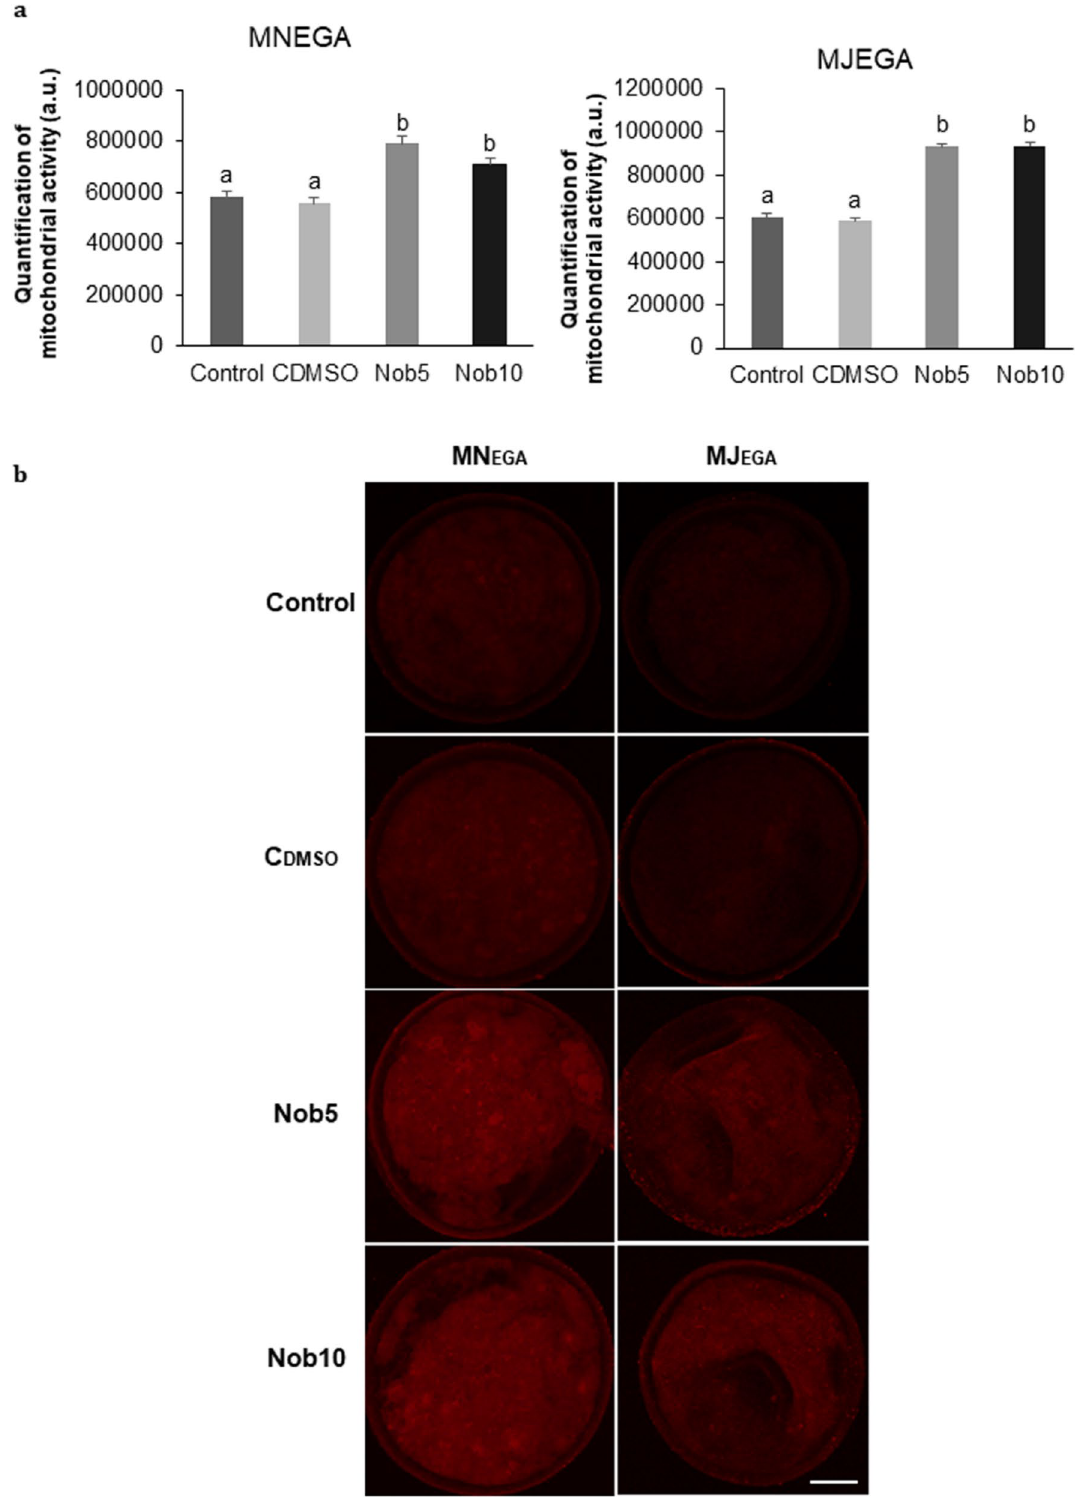
Figure 2. Nobiletin effect in blastocysts mitochondrial activity. ( a ) Quantification of mitochondrial fluorescence intensity in arbitrary units (a.u) in Day 7 blastocysts cultured in SOF + 5% FCS (Control), supplemented or not with 5 (Nob5) or 10 µM (Nob10) nobiletin or with 0.03% dimethyl sulfoxide (C DMSO ) during 21–54 hpi (MN EGA : presumptive zygote to 8-cell stage) or during 54–96 hpi (MJ EGA : 8- to 16-cell stage). Data are the mean ± s.e.m. Significant differences ( P < 0.001) are indicated with different letters. ( b ) Representative fluorescence images of mitochondrial activity in Day 7 blastocysts from all experimental groups (Control, Nob5 Nob10, C DMSO ) in both phases (MN EGA or MJ EGA ). Images were captured on 63× objective. Scale bar 50